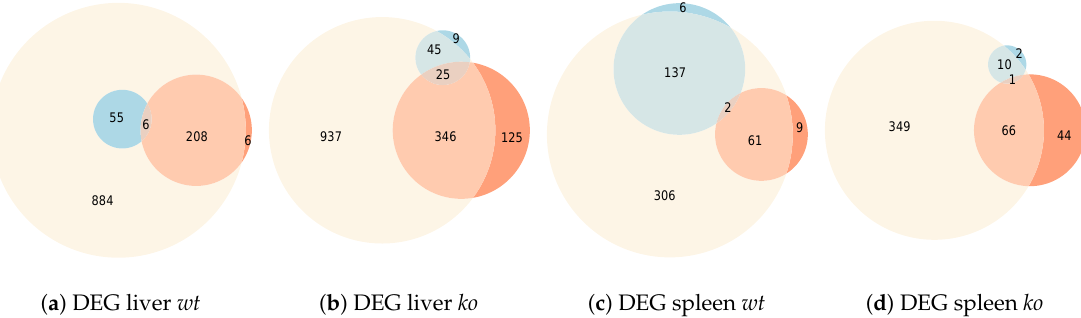
Figure 4. Euler diagrams showing the overlapping of DEG between the three possible contrast situations: control vs. cases at 3 d p.i. (red), control vs. cases at 5 d p.i. (yellow) and cases at 3 d p.i. vs. cases at 5 d p.i. (blue) ko refers to Ly6E ∆ HSC samples. These comparisons were performed both organ and genotype-wise considering four groups of samples: ( a ) liver wt , ( b ) liver Ly6E ∆ HSC , ( c ) spleen wt , ( d ) spleen Ly6E ∆ HSC